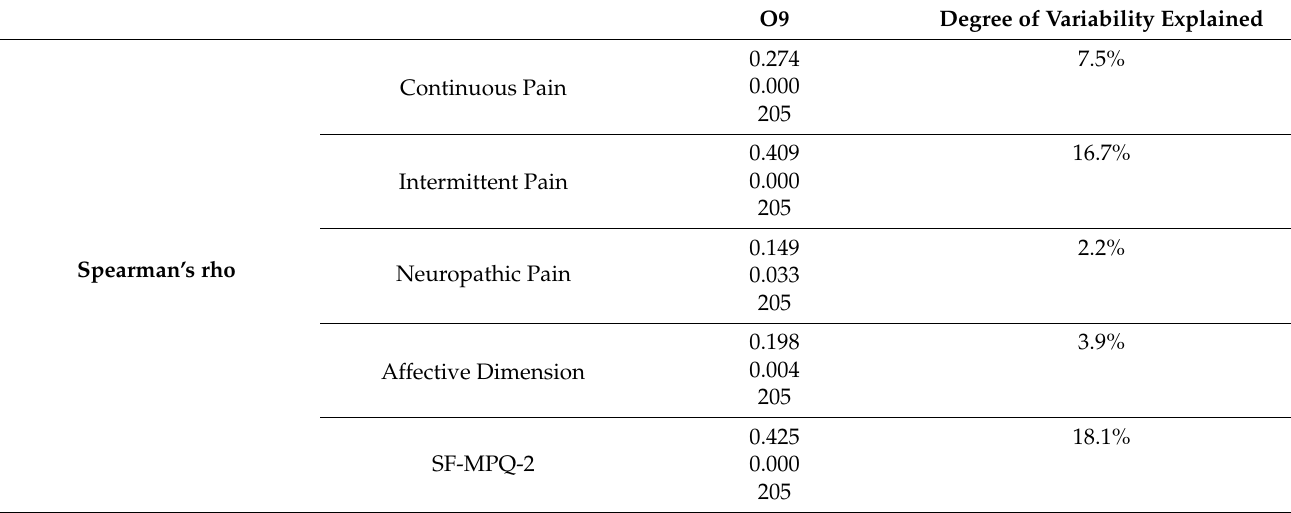
Table 2. Relationship between the current state of pain and the SF-MPQ-2 assessment (Spearman’s Rho).